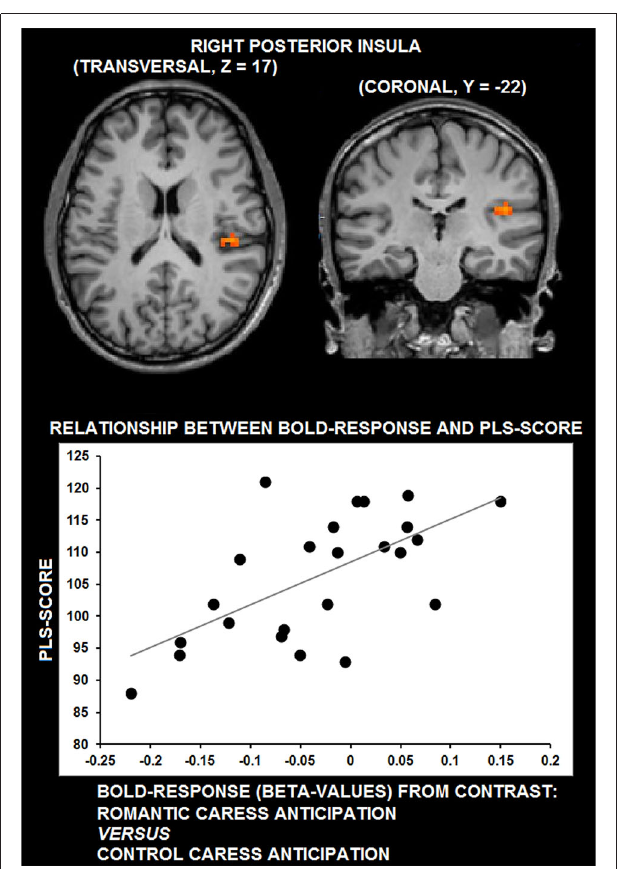
FIGURE 3 | Group statistical maps of right posterior insula activity covarying with PLS scores (thresholded at p < 0.01 corrected, corresponding to r > 0.63), and scatter plot depicting the correlation between anticipatory BOLD-response for romantic caress in posterior insula and PLS scores. FIGURE 4 | Graphs depicting BOLD-response in right posterior insula during the performance of romantic and control caress (* p < 0.05).